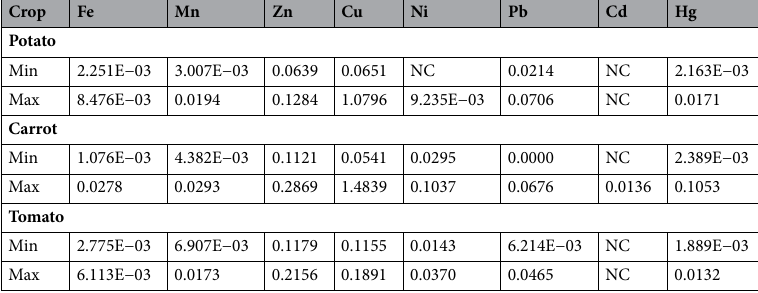
Table 9. Bioaccumulation factor (BAF). NC not